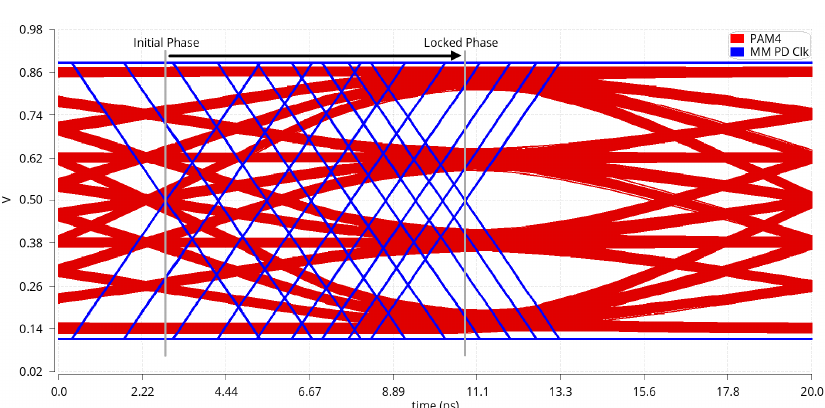
Figure 17. Clock and data relationship in DB PAM-4.